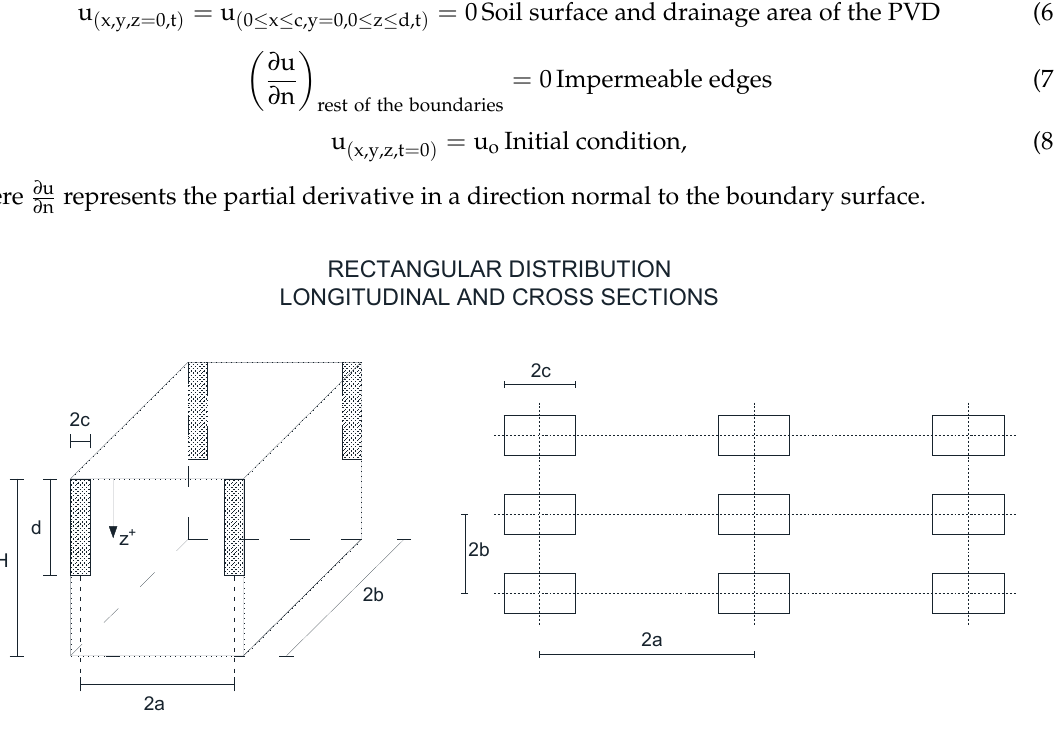
Figure 1. 3D rectangular consolidation problem with prefabricated vertical drains. Rectangular layout. Physical scheme ( left ) and section of the model ( right ).